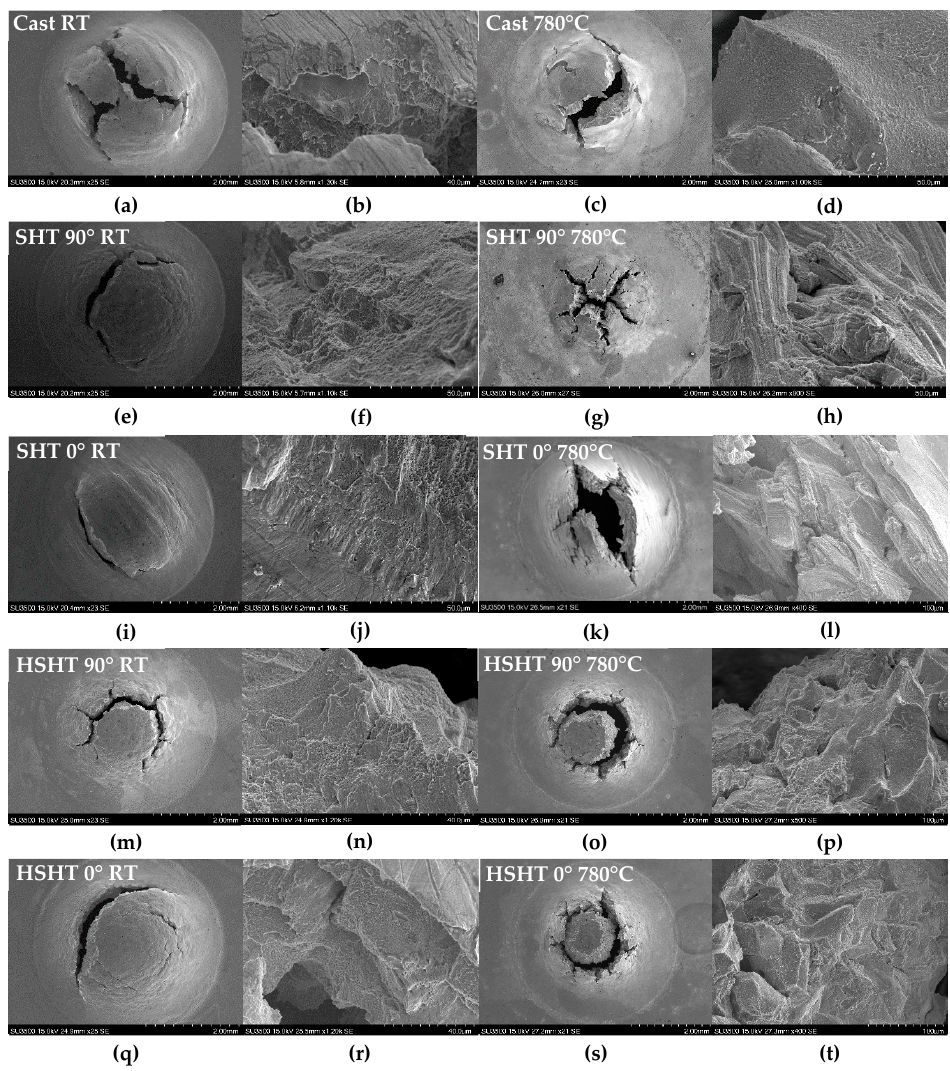
Figure 7. Macroscopic and microscopic micrographs of SPT disc fracture surfaces: ( a , b ) cast RT; ( c , d ) cast 780 °C; ( e , f ) SHT 90° RT; ( g , h ) SHT 90° 780 °C; ( i , j ) SHT 0° RT; ( k , l ) SHT 0° 780 °C; ( m , n ) HSHT 90° RT; ( o , p ) HSHT 90° 780 °C; ( q , r ) HSHT 0° RT; ( s , t ) HSHT 0° 780 °C.